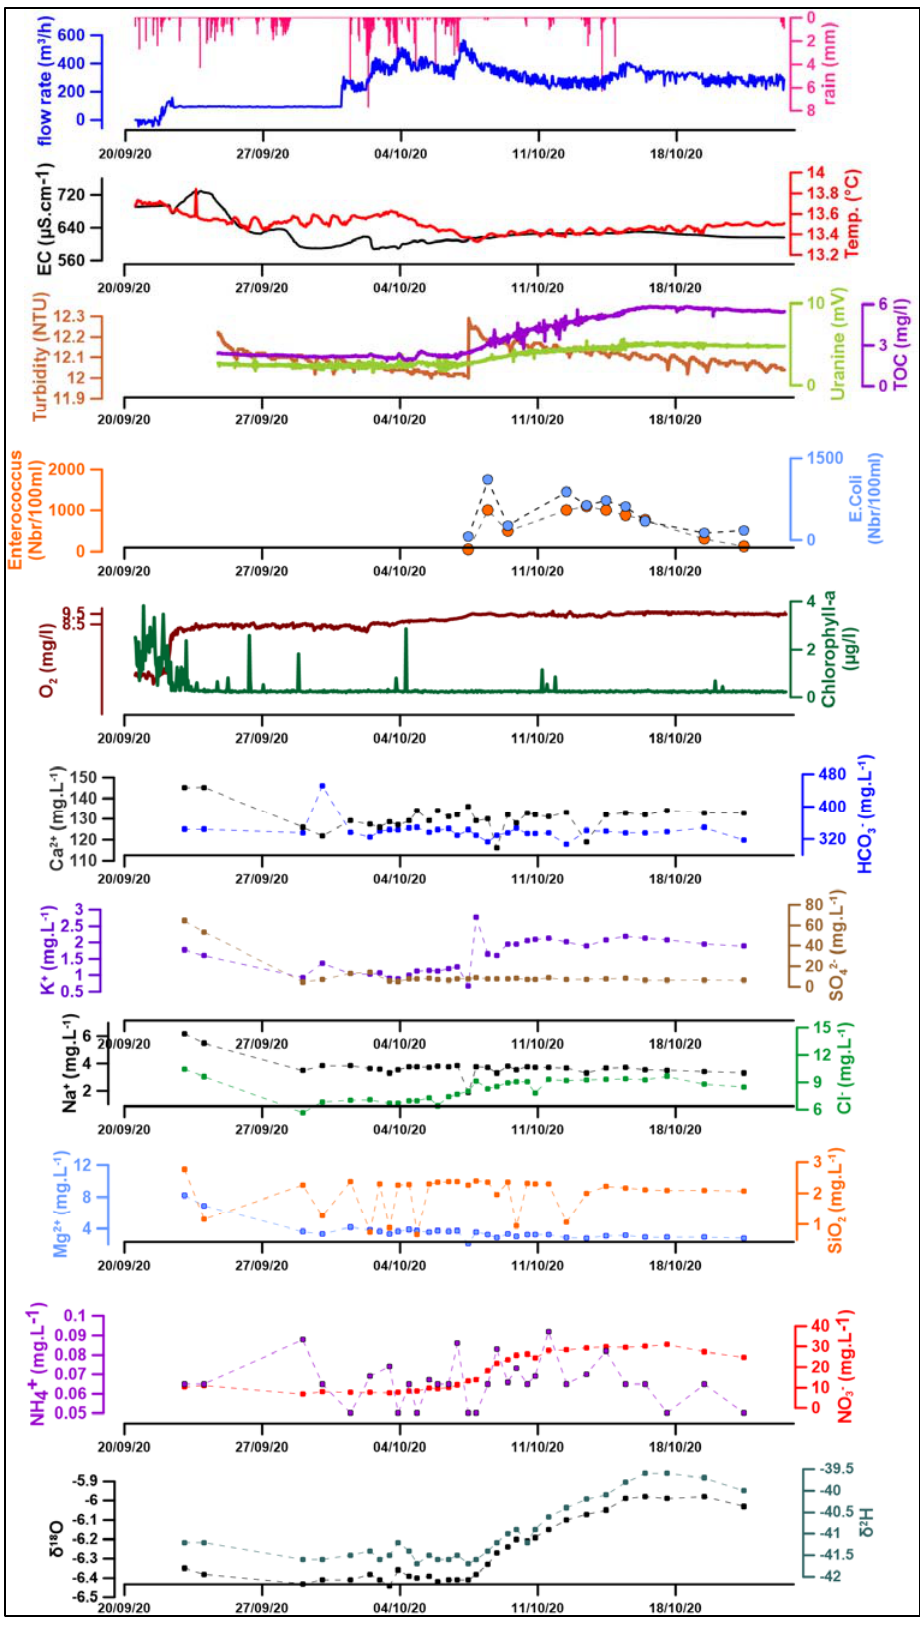
Figure B6. Chemiograph of the Fontbelle spring from 20/09/20 to 21/10/20. Figure A9. Chemiograph of the Fontbelle spring from 20/09/20 to